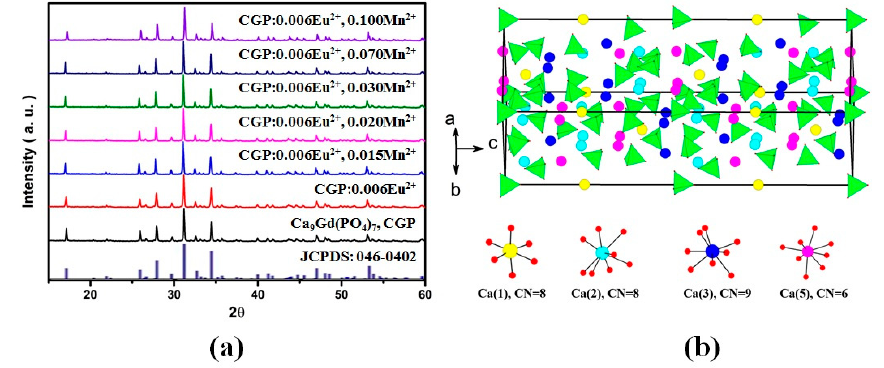
Figure 2. ( a ) XRD patterns of the representative CGP, CGP:0.006Eu 2+ , x Mn 2+ ( x = 0.015–0.1) phosphors, and standard pattern Ca 9 Y(PO 4 ) 7 (JCPDS 46-0402); ( b ) Representation of the Ca 9 Gd(PO 4 ) 7 supercell and four different coordinations of Ca 2+ ions.